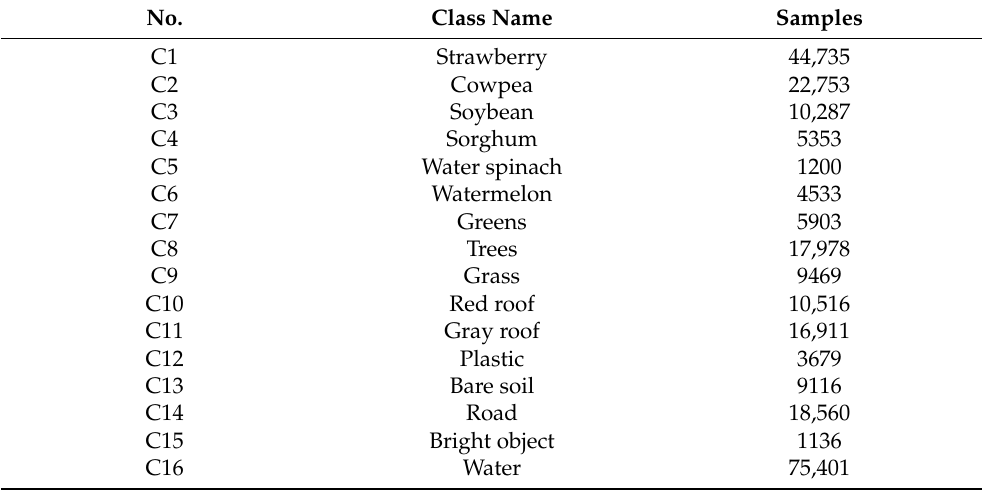
Table 2. Ground truth classes for the HanChuan dataset and the corresponding sample number.